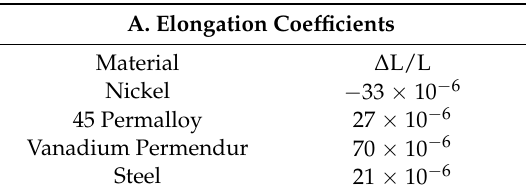
Figure 7. Resulting magnetic field on the strip. Table 2. Elongation coefficient of analysed magnetostrictive materials. Table 2. Elongation coefficient of analysed magnetostrictive materials.